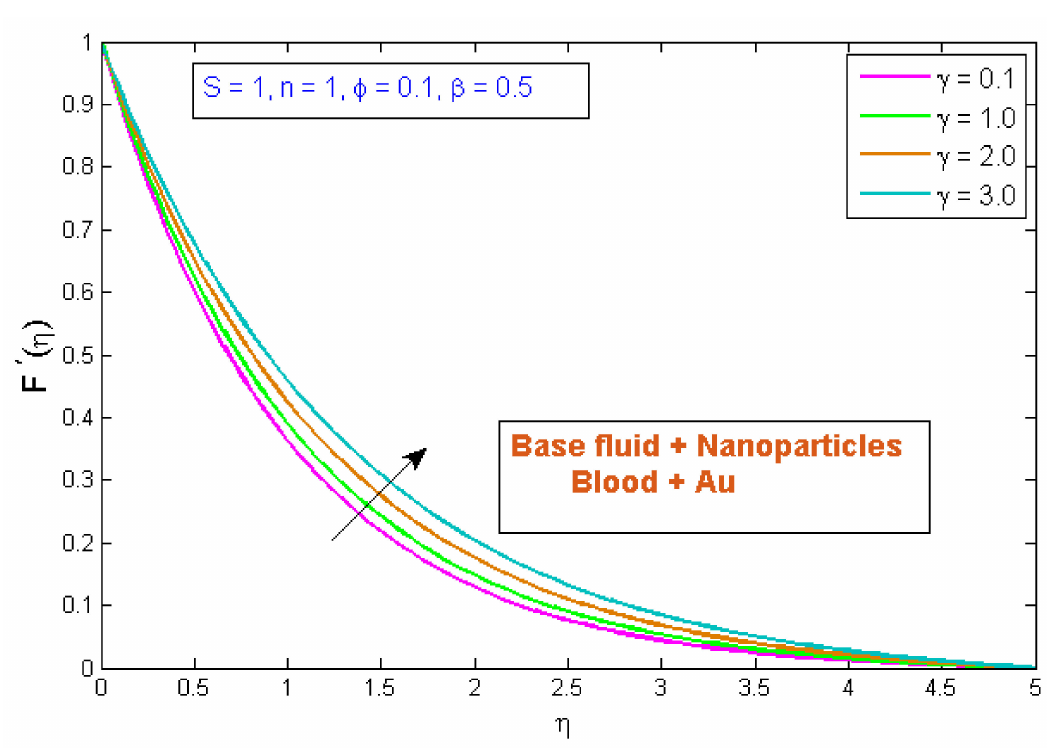
Figure 5. Modification of F (cid:48) ( η ) versus γ